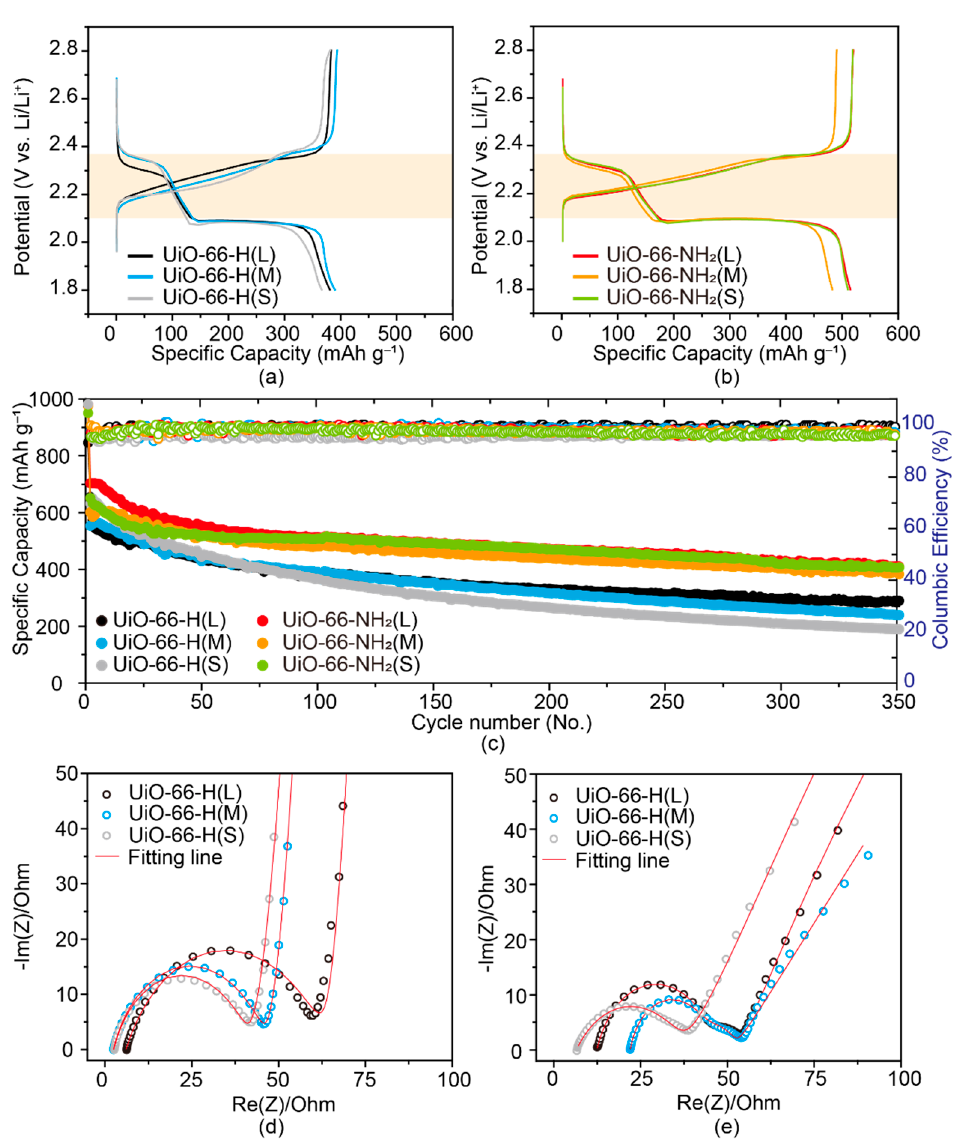
Figure 5. Electrochemical performance of Li–S batteries with MOF-coated separators at 250 mAg − 1 . Voltage profiles at 250 mAg − 1 (the 100th cycle) for cells assembled with: ( a ) UiO-66-H(X) and ( b ) UiO-66-NH 2 (X) coated separators. ( c ) Long-term cycling performance of UiO-66-H(X) and UiO-66-NH 2 (X) with first cycle at 100 mAg − 1 . Nyquist plots of ( d ) fresh cells and ( e ) after 350 cycles using UiO-66-H(X) coated separators.